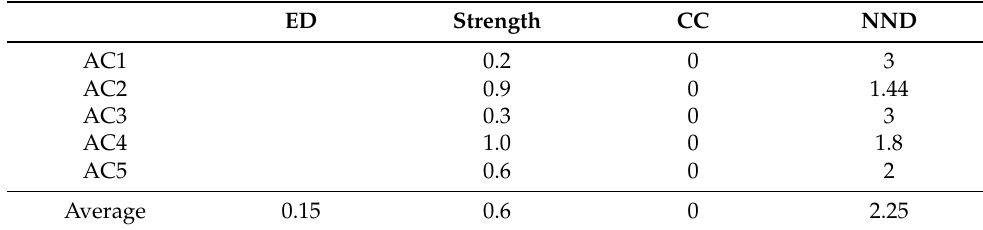
Table 2. Complexity indicators for G 2